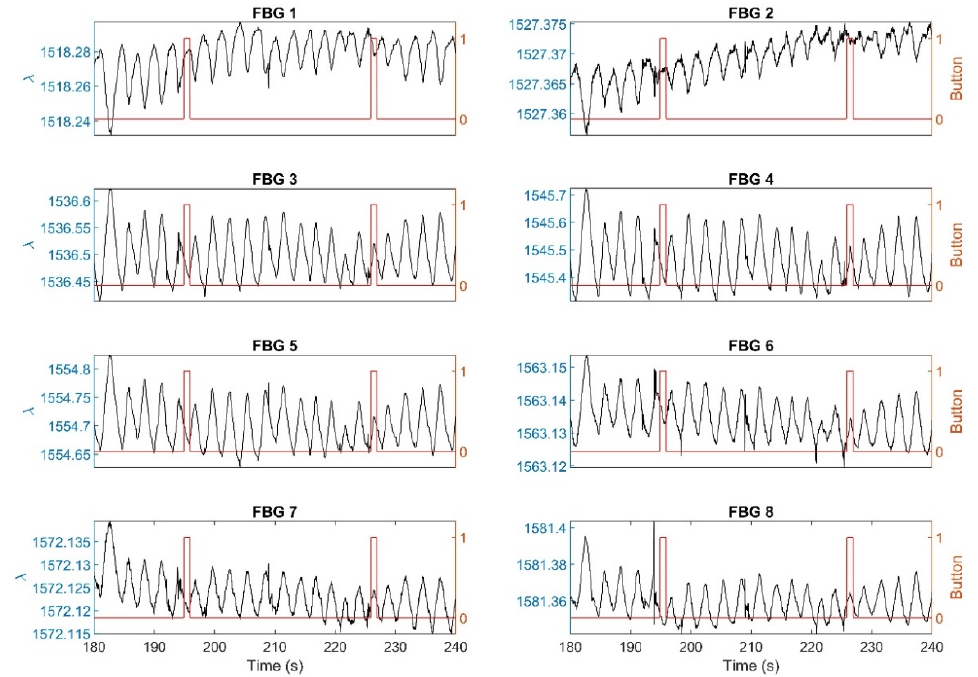
Figure 10. Experimental results show that the mother perceived two movement, while FBG sensors detected three distortions. The black line with the left y axis shows the response of the sensor. The red line with the right y axis shows the mother’s perception.